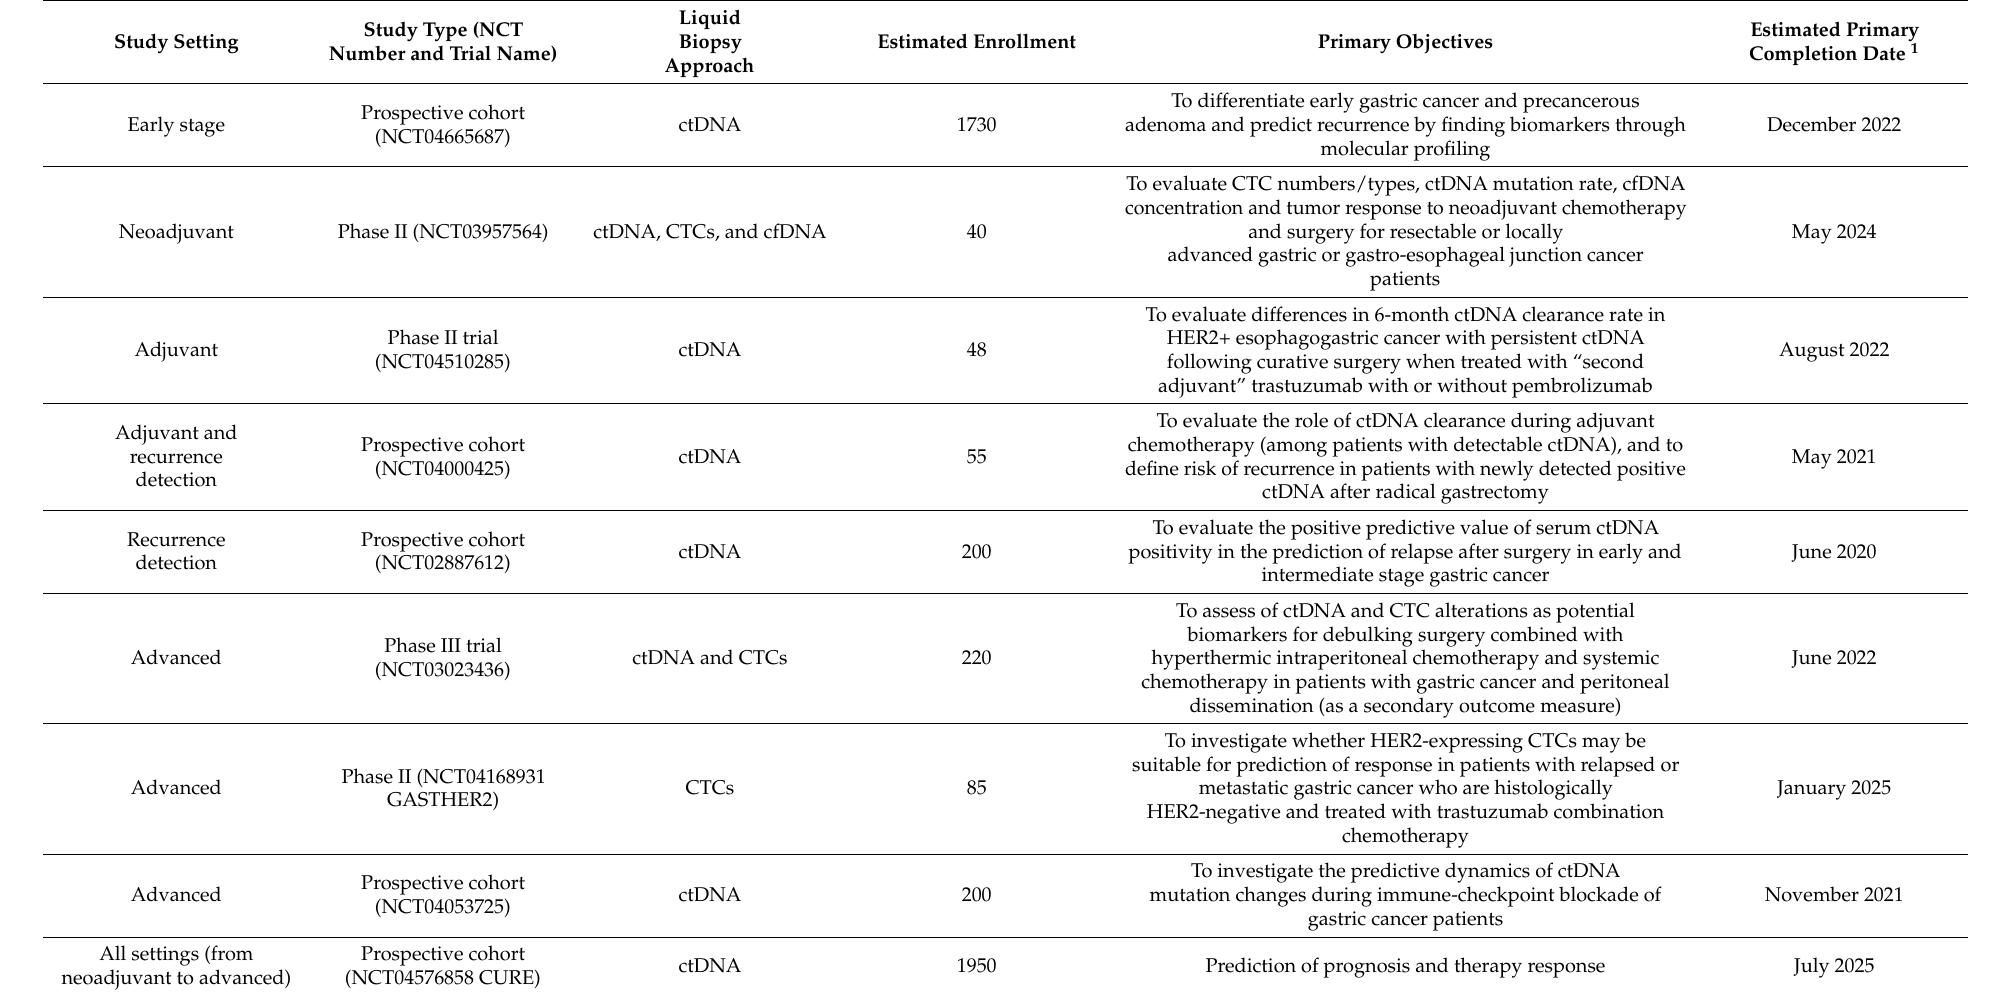
Table 1. Ongoing clinical trials using liquid biopsy approaches for gastric